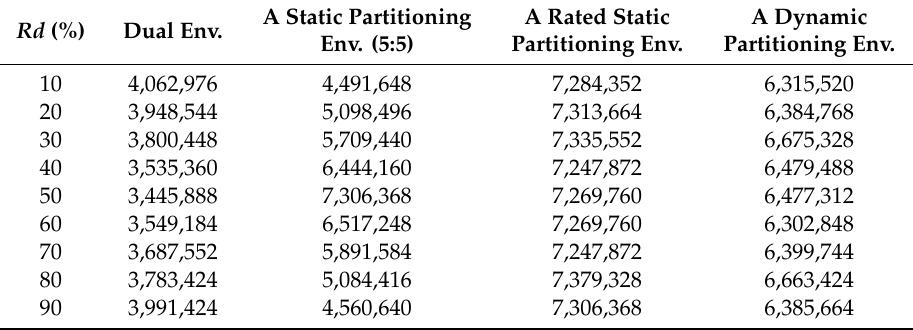
Table 4. Experimental results of each Environment according to the ratio of packets (size of one packet: